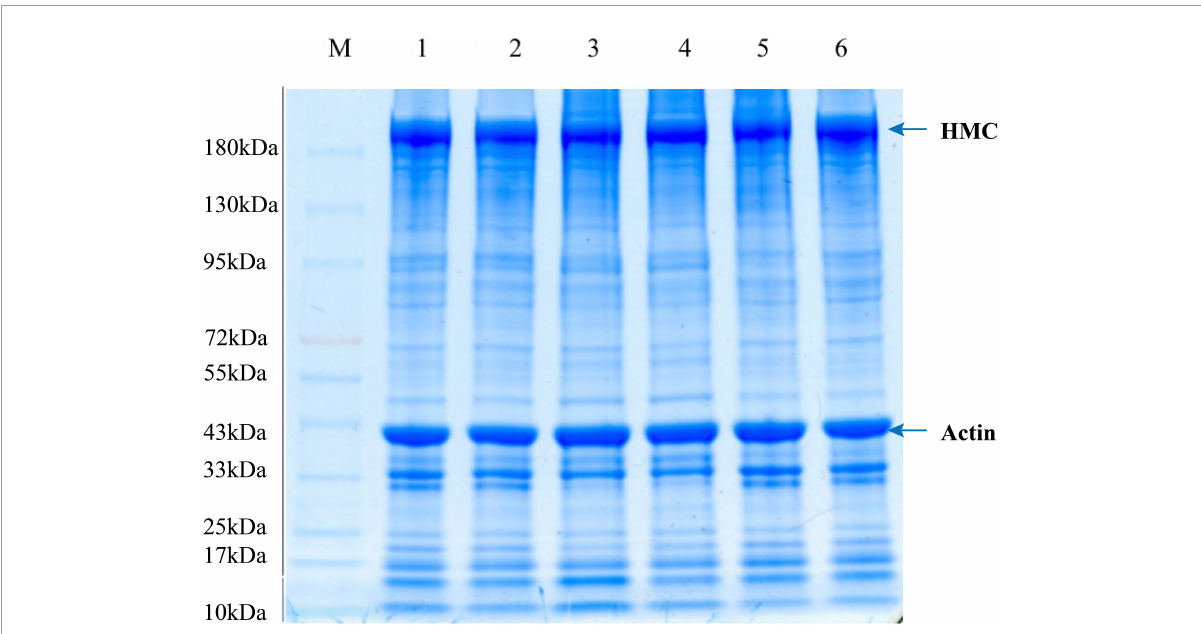
FIGURE7 Changes in SDS-PAGE of LYC during frozen storage. 1, 2 are fresh samples of LYC, 3, 4, and 5, 6 are SDS-PAGE profiles of total protein of LSS group and SFS group after 4 F-T cycles and 6w frozen storage,